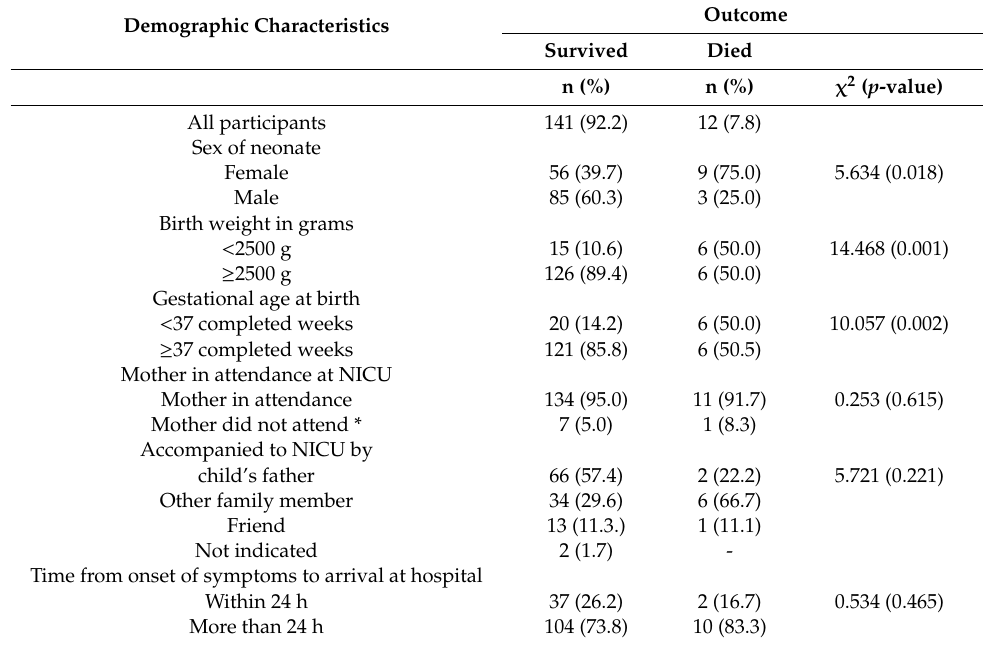
Table 1. Characteristics of outborn neonates referred to UWRH and